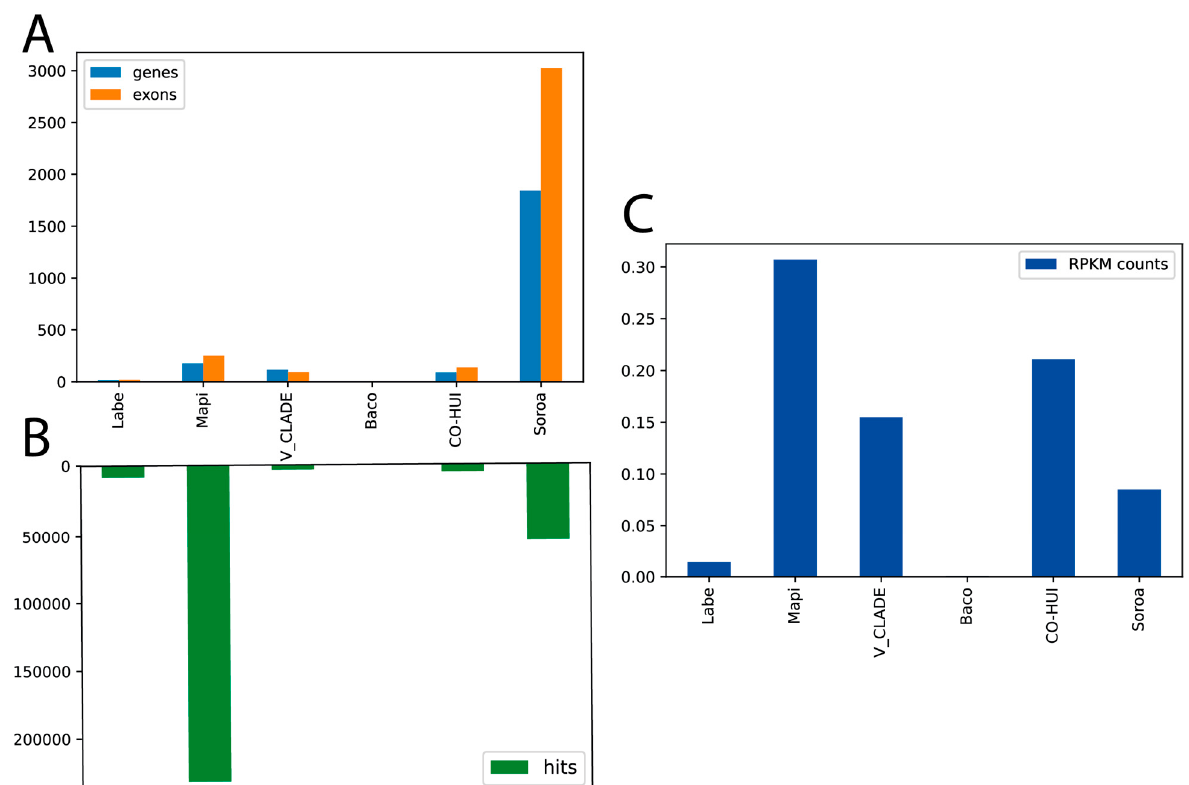
Figure 5. Number of LTR-RTs inserted into to annotated genes and exons. ( A ) The intersection be- tween the LTR-RT elements and genes and exons in the Hv33 genome. ( B ) The co-expression anal- ysis of Pucciniales between the annotated genes and LTR-RTs. The co-expression is represented as numbers of hits for each lineage. ( C ) RNAseq expression of the LTR-RTs. The RNAseq hits were normalized using RPKM (reads per kilobase million), which used the average length of each ele- ment’s